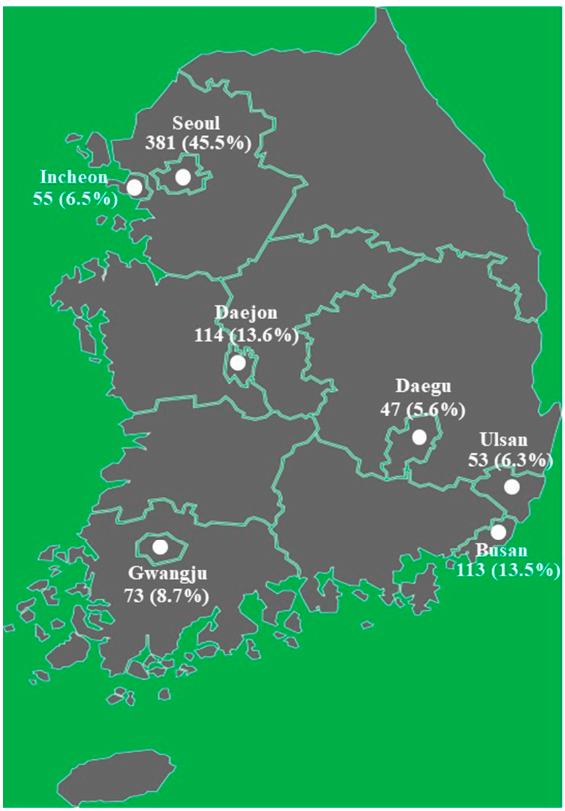
Figure 2. Location of E. coli isolates collection cities in Korea.